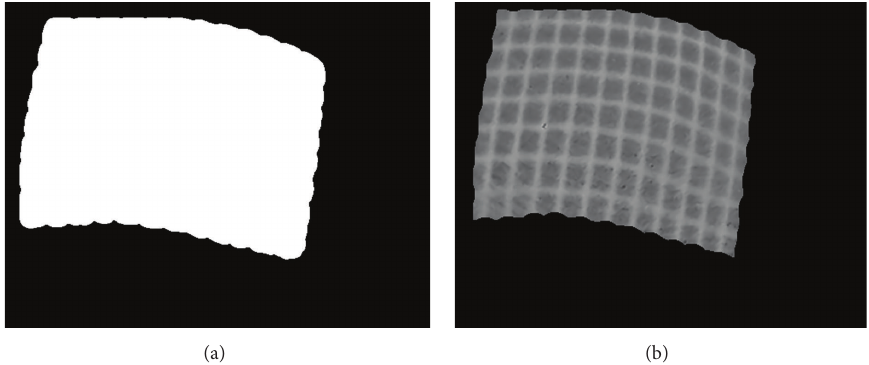
Figure 7: (a) Detected ROI mask image and (b) intensity correction image within ROI